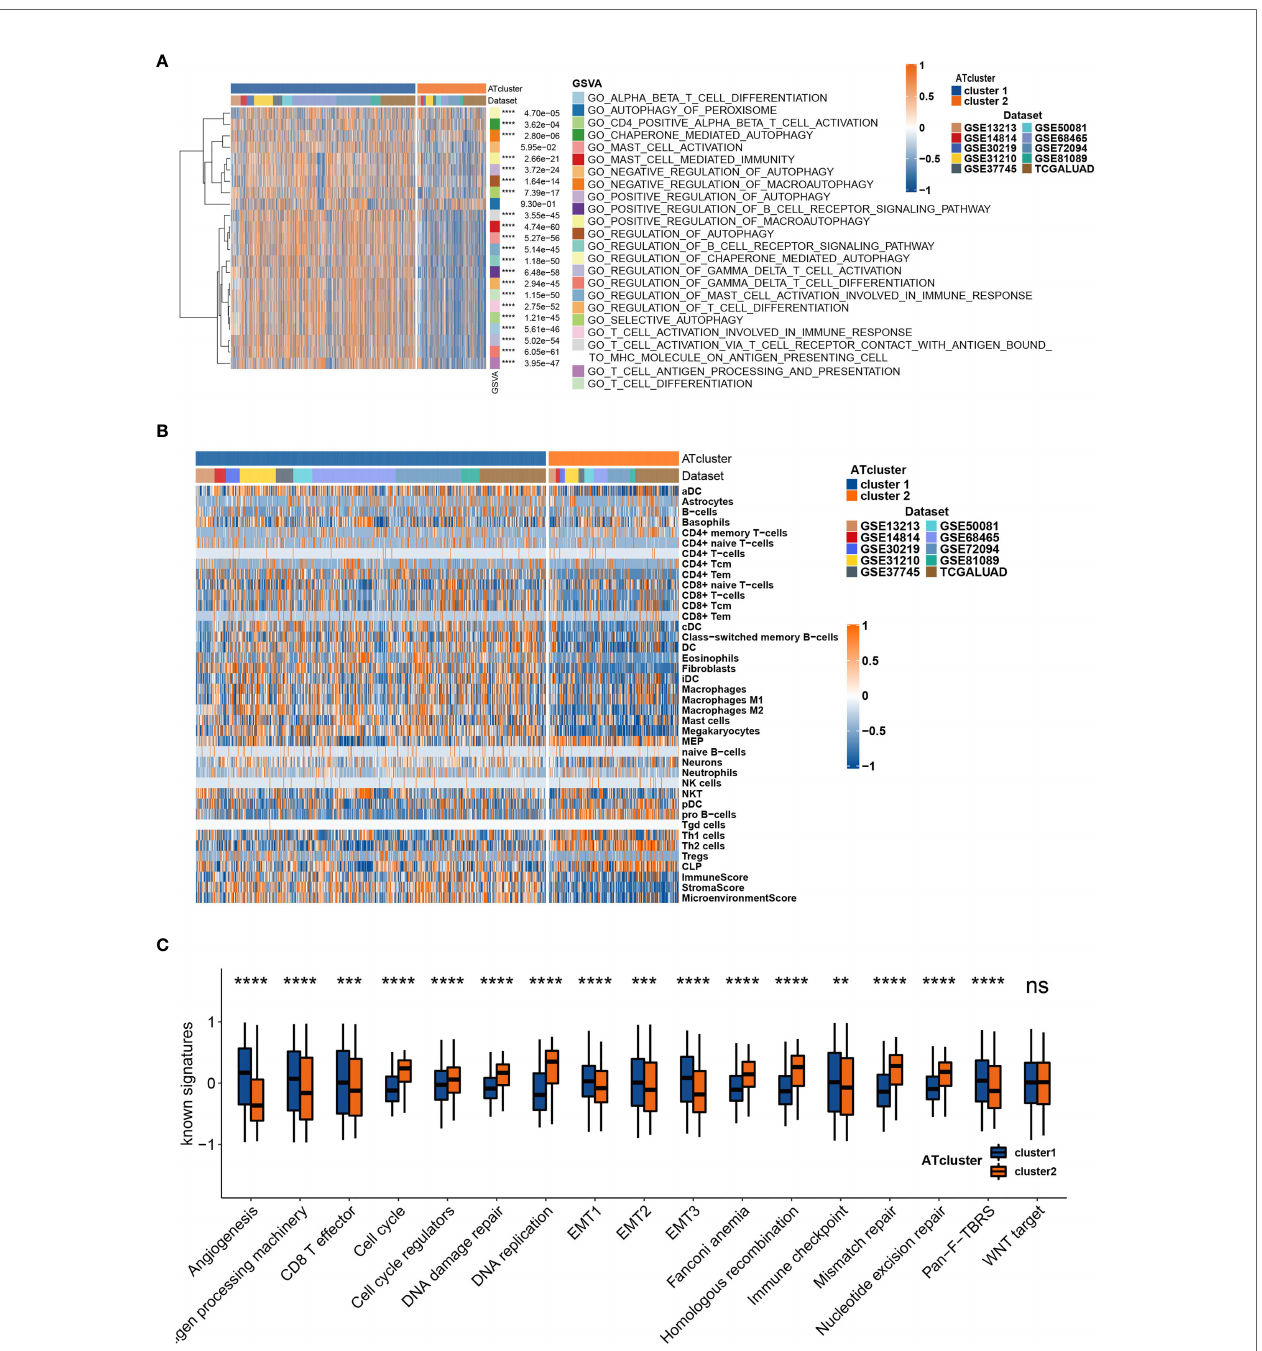
FIGURE 3 | The transcriptome features of autophagy clusters in the meta-cohort. Unsupervised clustering assays showed that immune and autophagy-related biological functions were enriched in meta-cohort samples (A) , and the two autophagy clusters (ATcluster) have different immune in fi ltrating cells patterns (B) . The two autophagy clusters had different well-known signature patterns in the meta-cohort (C) . **P<0.01, ***P<0.001, ****P<0.0001. “ ns ” means no signi fi